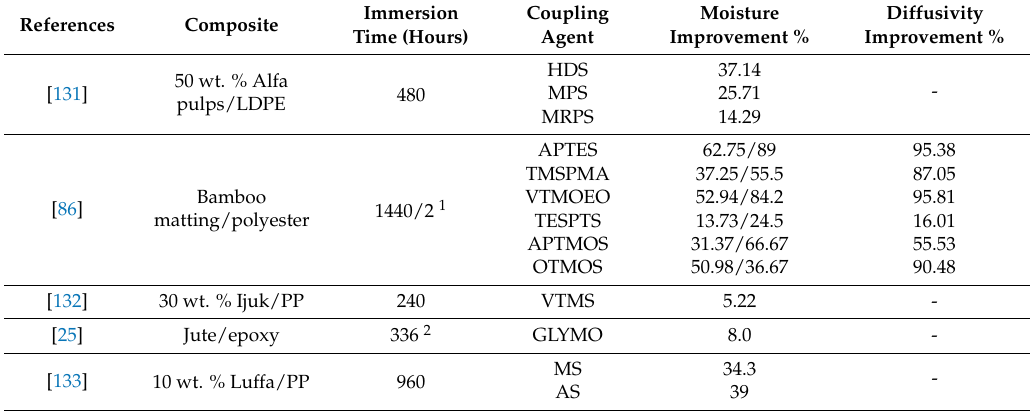
Table 1. The improvements on moisture absorption properties attained from using coupling